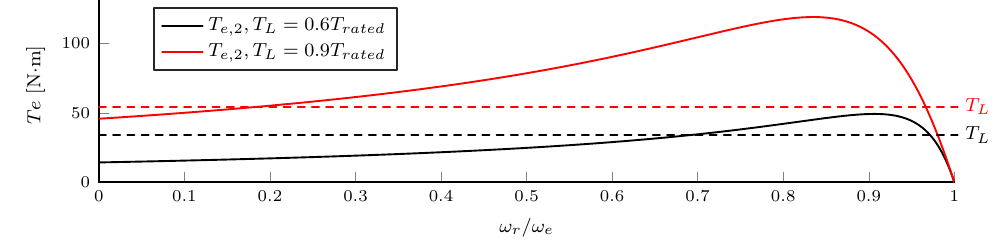
Figure 30. Electromagnetic torque of secondary motor for different values of average external stator resistance: torque sufficiency